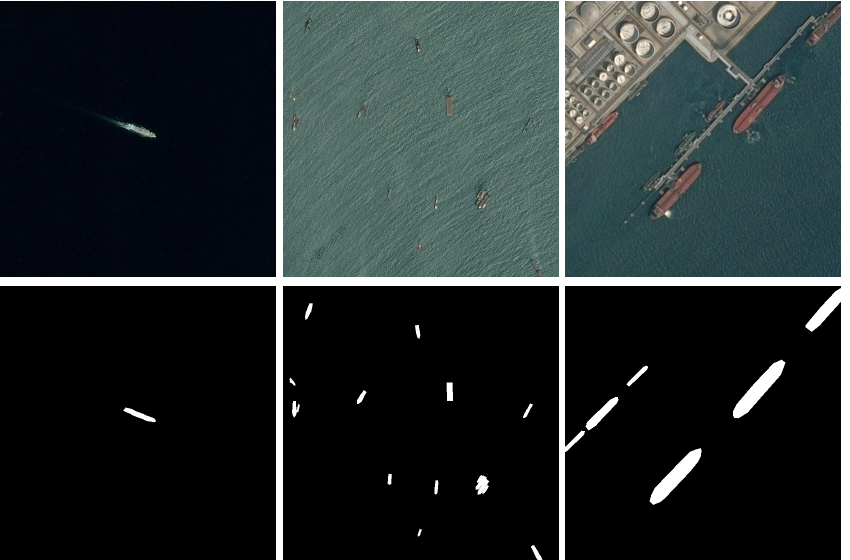
Figure 2. Example of segmentation of maritime surveillance images, taken from the Airbus ship detection dataset [6]. Top: original images. Bottom: corresponding ship segmentation